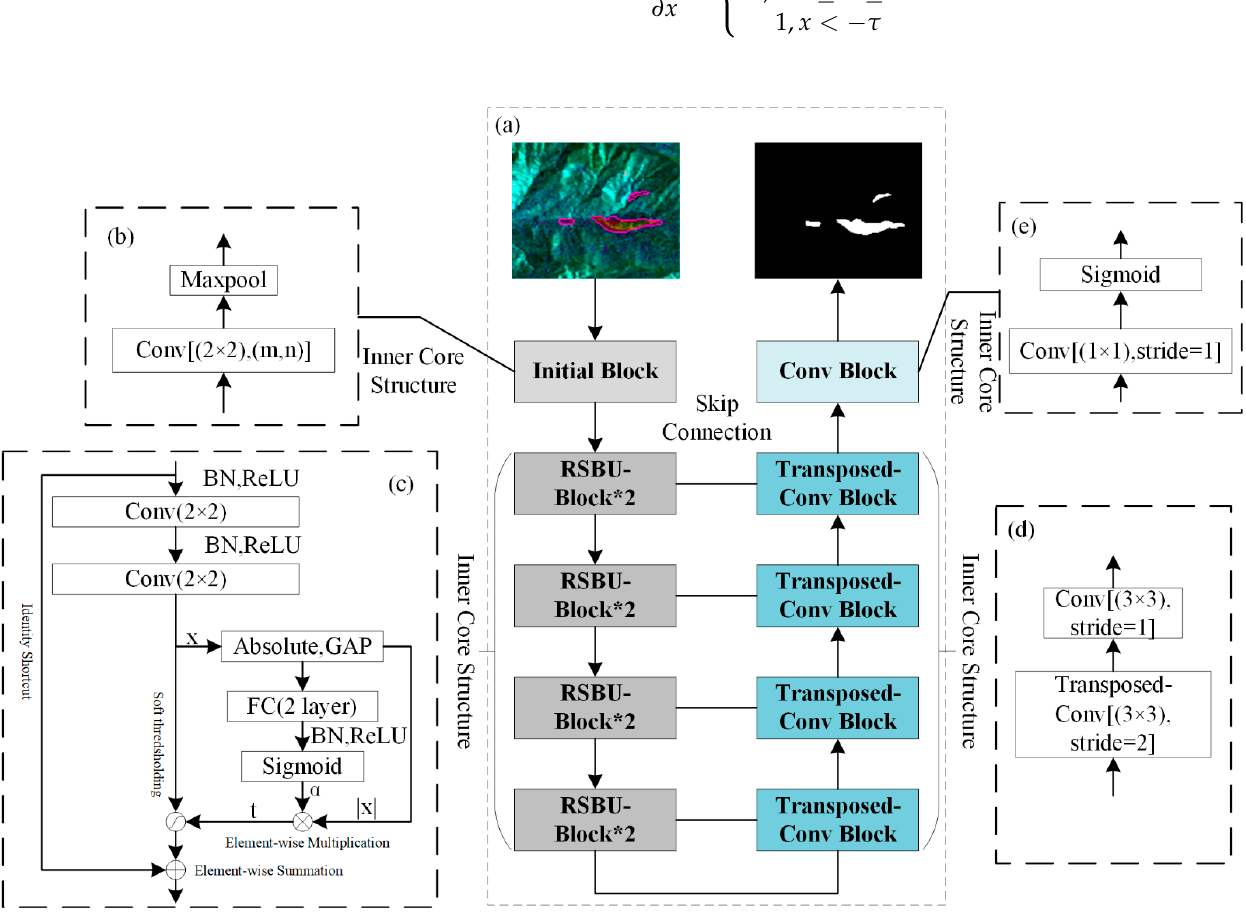
Figure 7. Schematic of the proposed DRs-UNet: ( a ) overall structure of DRs-UNet; ( b ) initial block; ( c ) inner core structure of RSBU-block; ( d , e ) inner core structure of transposed convolution block (TCB) and the final convolution block.